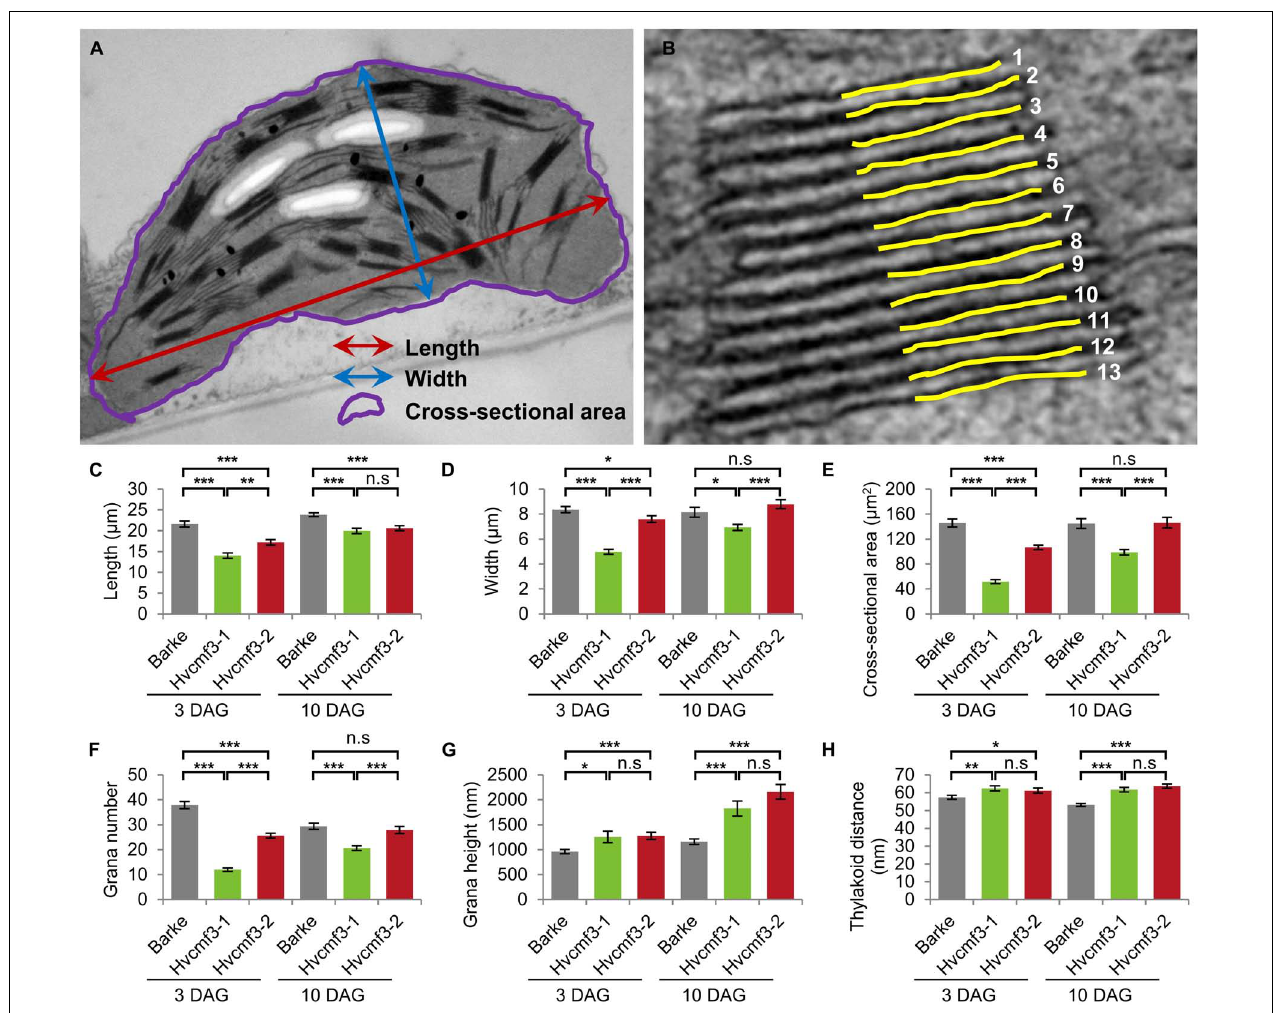
FIGURE 8 | Quantification of chloroplast architecture components. (A) Diagram for demonstrating the chloroplast length, width, and surface area. (B) Illustration demonstrating the counting of thylakoid. (C–H) Comparison of chloroplast morphology and grana architecture between wild type and Hvcmf3 mutants at developmental stages 3 days after germination. Chloroplast length (C) , chloroplast width (D) , chloroplast cross-sectional area (E) , grana number (F) , grana height (G) , and thylakoid distance (H) . Results are presented as means ± SE. t-test significant level: * p < 0.05; ** p < 0.01; *** p < 0.001, n.s, not significant. Number of chloroplast analyzed n ≥ 24. The exact p -values are provided in Supplementary Dataset 6